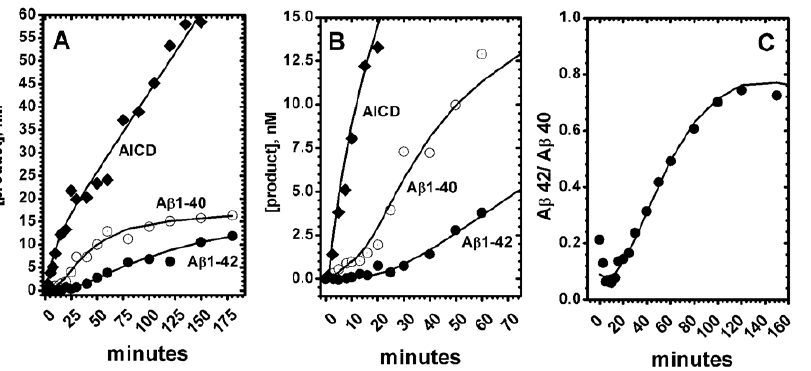
Figure 1. Different phases in c -secretase reaction can be separated in time. The reactions were prepared using CHAPSO enriched c - secretase membranes (total protein 0.25 mg/ml) and saturating concentration of C99 substrate (3.0 m M). (A–B). Early time points and the pre-steady- state [62] for AICD, A b 1–40 and A b 1–42 production (panel B is zoom-in on panel A). The best-fit profile for AICD production was calculated using the equation for pre-steady-state burst (eqn. 1, Table 1), while the best-fit profiles for A b 1–40 and A b 1–42 production were calculated using the equation for enzyme hysteresis (eqn. 2, Table 1). (C) The time profiles A b 1–40 and A b 1–42 from figure 1 were used to calculate the changes in A b 42/ A b 40 ratio as a function of the reaction time (A b 42/A b 40 ratio is shown, rather than A b 40/A b 42 ratio, in an attempt to follow standards in the literature).